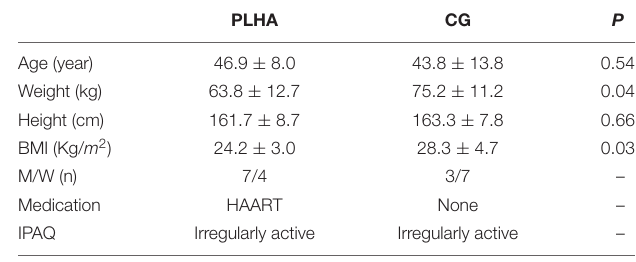
TABLE 1 | Training intervention protocol. TABLE 2 | Descriptive characteristics of the PLHA and